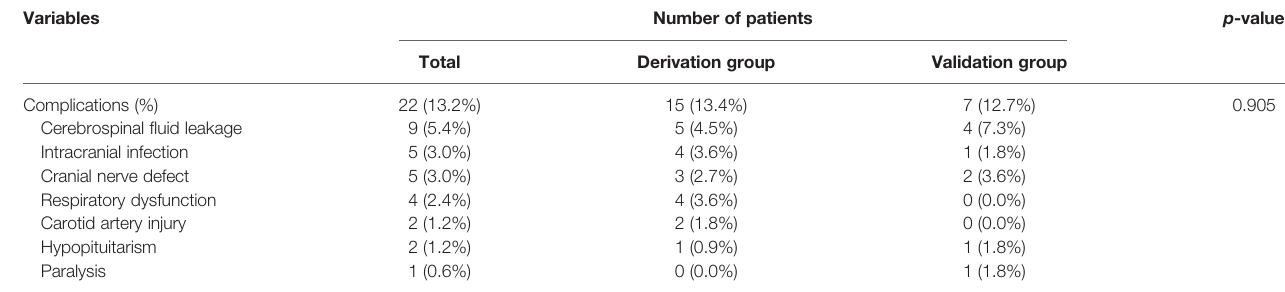
TABLE 5 | Surgical complications in skull base chordoma